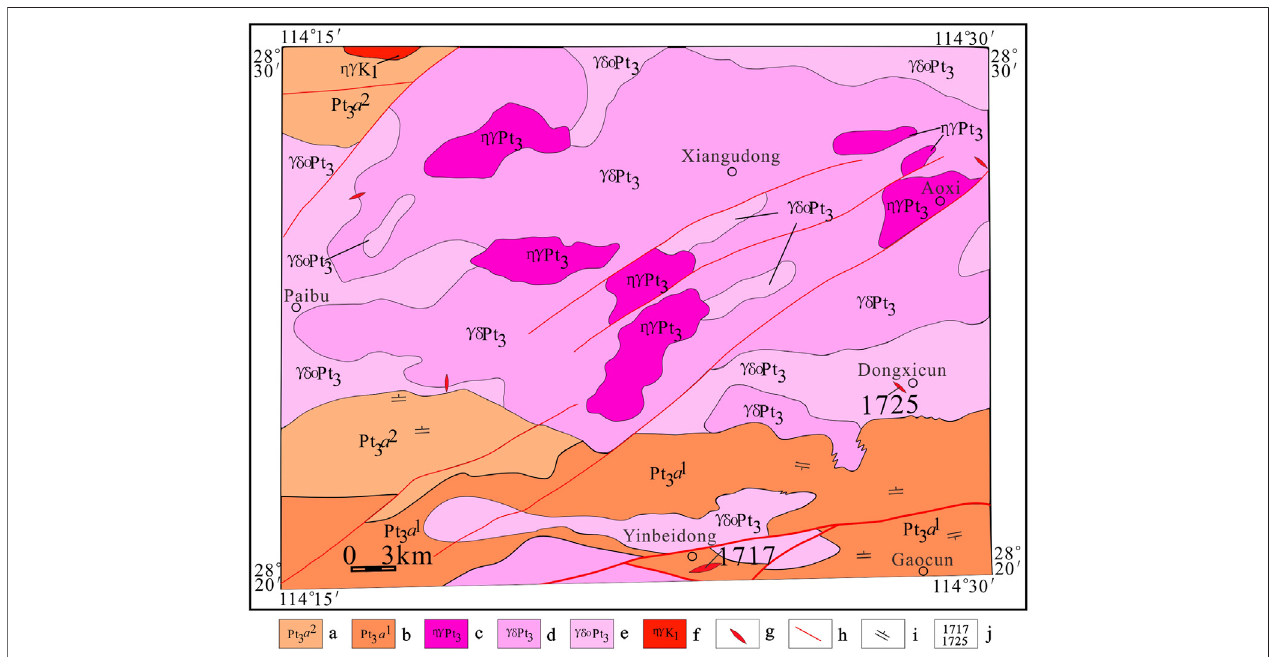
FIGURE 2 | Regional geological map in Yichun area of Jiangxi province and location of the samples (after the author participated in the 1:50,000 Gaocun, Daqiao and Xujiadu regional geological survey project). a-Middle member of Neoproterozoic Anlelin Formation, b-Lower member of Neoproterozoic Anlelin Formation, c-Neoproterozoic monzogranite, d-Neoproterozoic granodiorite, e-Neoproterozoic tonalite, f-Late Cretaceous monzogranite, g-Acid dykes, h-Fault, i-Attitude of schistosity, j-Sampling location and number.